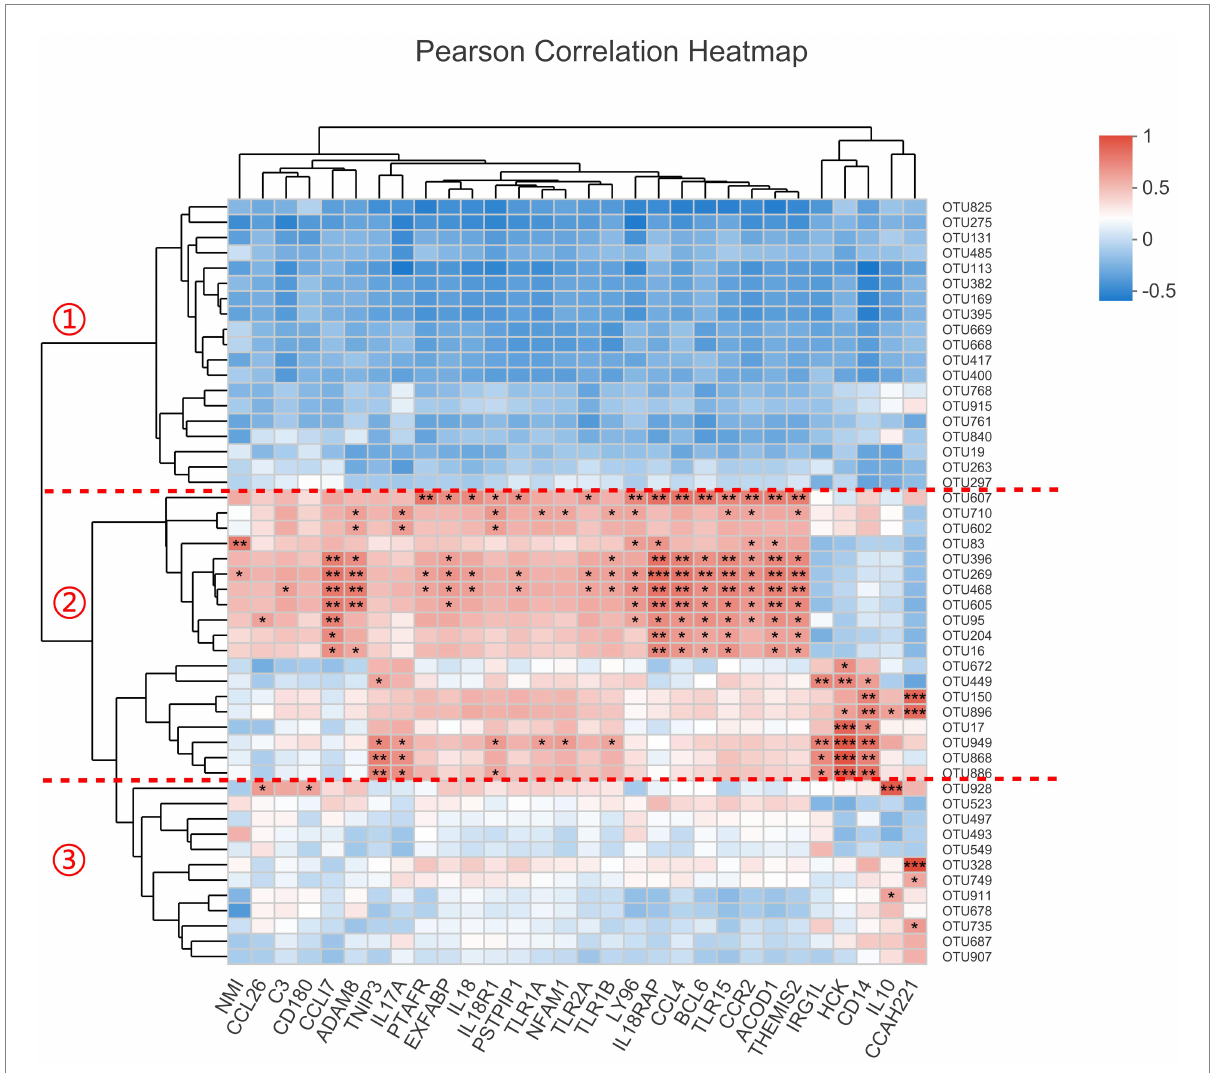
FIGURE 6 The correlation analysis between the top50 OTUs and 30 inflammation-related genes. The significant level in figure is marked as *(0.01 ≤ p < 0.05), **(0.001 ≤ p < 0.01), and ***( p <